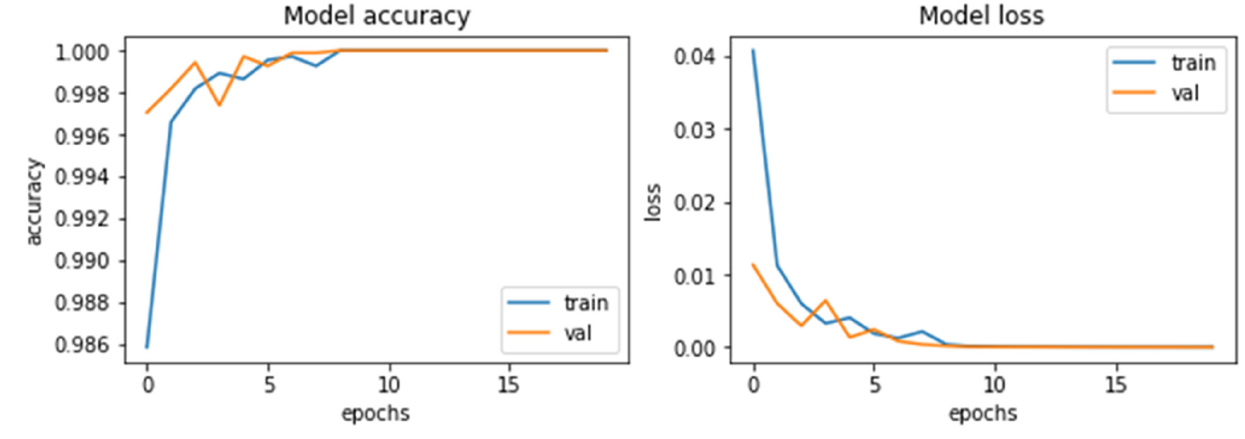
Figure 11. Accuracy and loss curves of VGG19 architecture.